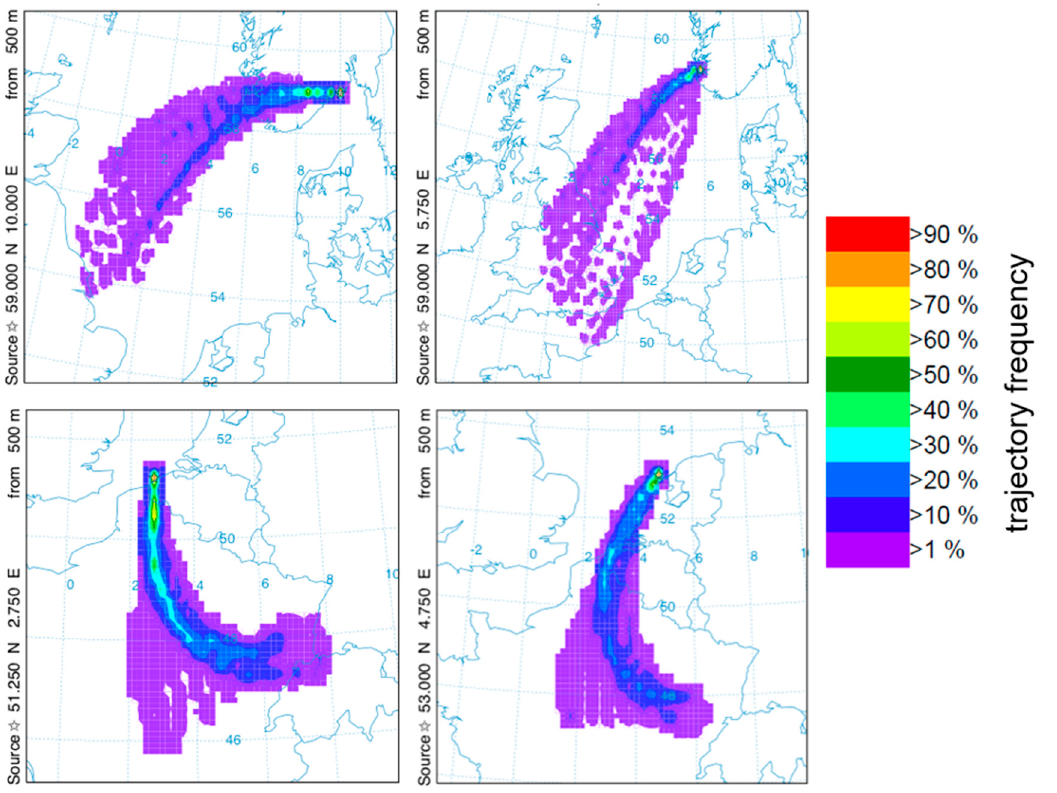
Figure 7. Forward trajectories from four starting locations in Norway (top left; source location 58.968° N, 9.905° E; top right; source location 59.002° N, 5.719° E), Belgium (lower left; source location 51.185° N, 2.82° E), and the Netherlands (lower right; source location 53.088° N, 4.795° E). The trajectories were started every 3 h from 19:00 on 29 May 2016 to 19:00 on 31 May 2016 and flight height was set as 500 m with a 24-h flight duration.